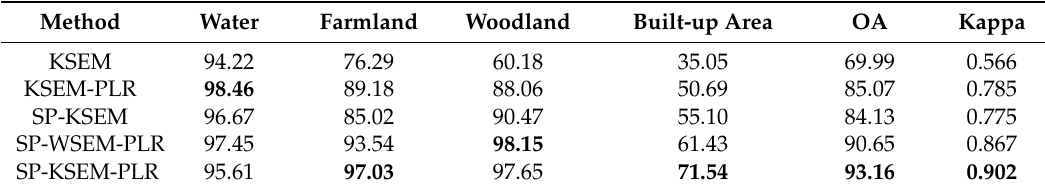
Figure 10. Classification results of the AIRSAR image with different methods: ( a ) superpixel map; ( b ) KSEM; ( c ) KSEM-PLR; ( d ) SP-KSEM; ( e ) SP-WSEM-PLR; and ( f ) SP-KSEM-PLR. Table 2. Classification accuracy measures of the RADARSAT-2 image.